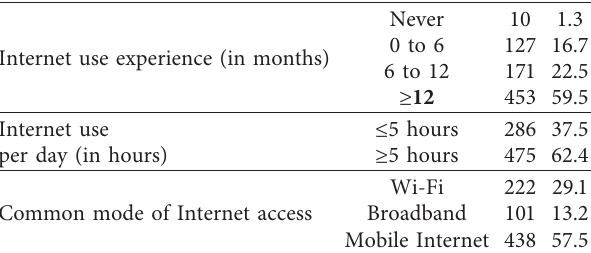
Table 2: Internet access and experience of Dilla University un- dergraduate students, Dilla, Ethiopia, in